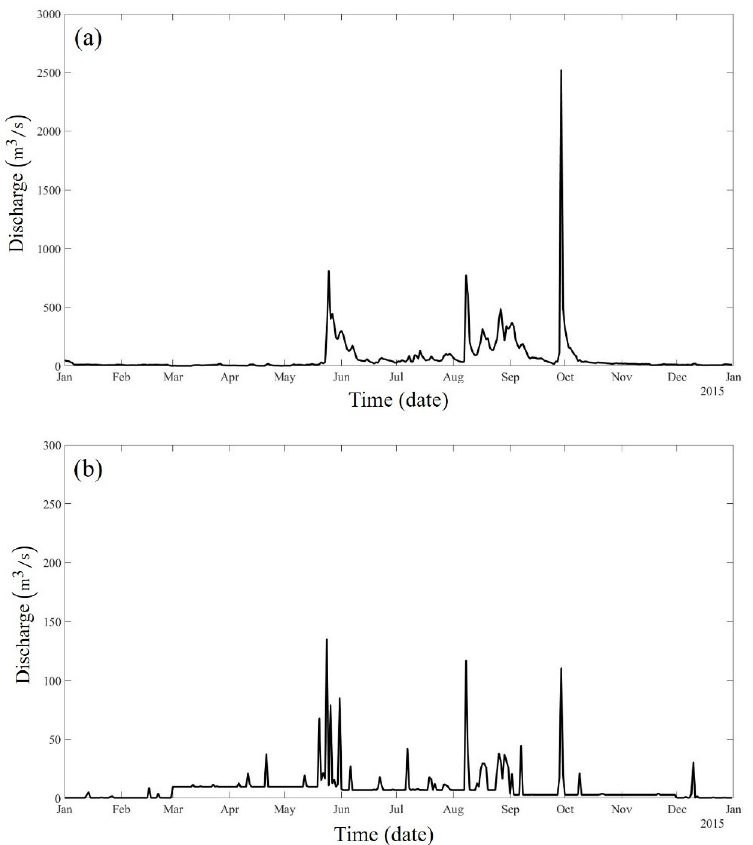
Figure 7. Time-series discharges estimated from the two catchment areas of CS (upper panel; 3156.9 km 2 ) and NHW (bottom panel; 109.3 km 2 ) rivers presented an average value of approximately 20 m 3 /s in ( a ) and 10 m 3 /s in ( b ) in 2015, respectively. Water 2022 , 14 , x FOR PEER REVIEW